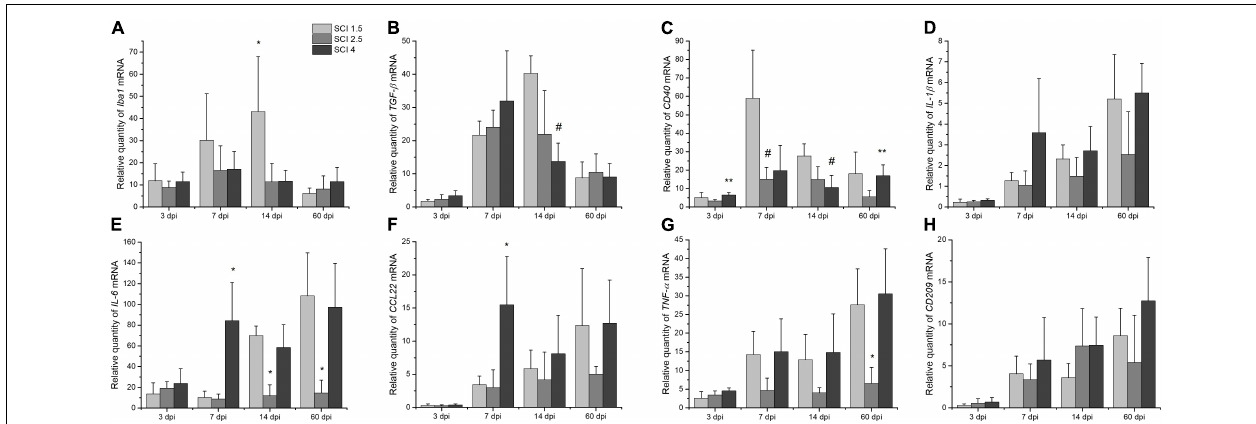
FIGURE 4 | Analysis of mRNA expression in the area of SCI in rats. Relative quantity of Iba1, TGF- β , CD40, IL-1 β , IL-6, CCL22, TNF- α , and CD209 mRNA expression (A–H) at 3, 7, 14, and 60 days after spinal cord injury of mild (SCI 1.5, a light gray column), moderate (SCI 2.5, a gray column), and severe (SCI 4, a black column) severities ( n = 5 in each group and each of the above dpi), calculated in relation to intact spinal cord controls, which were considered as 1. The mRNA expression was normalized using GAPDH rRNA. *p < 0.05 as compared with all investigated groups; **p < 0.05 as compared with the SCI 2.5 group; # p < 0.05 as compared with the SCI 1.5 group, one-way ANOVA, followed by a Tukey’s post hoc